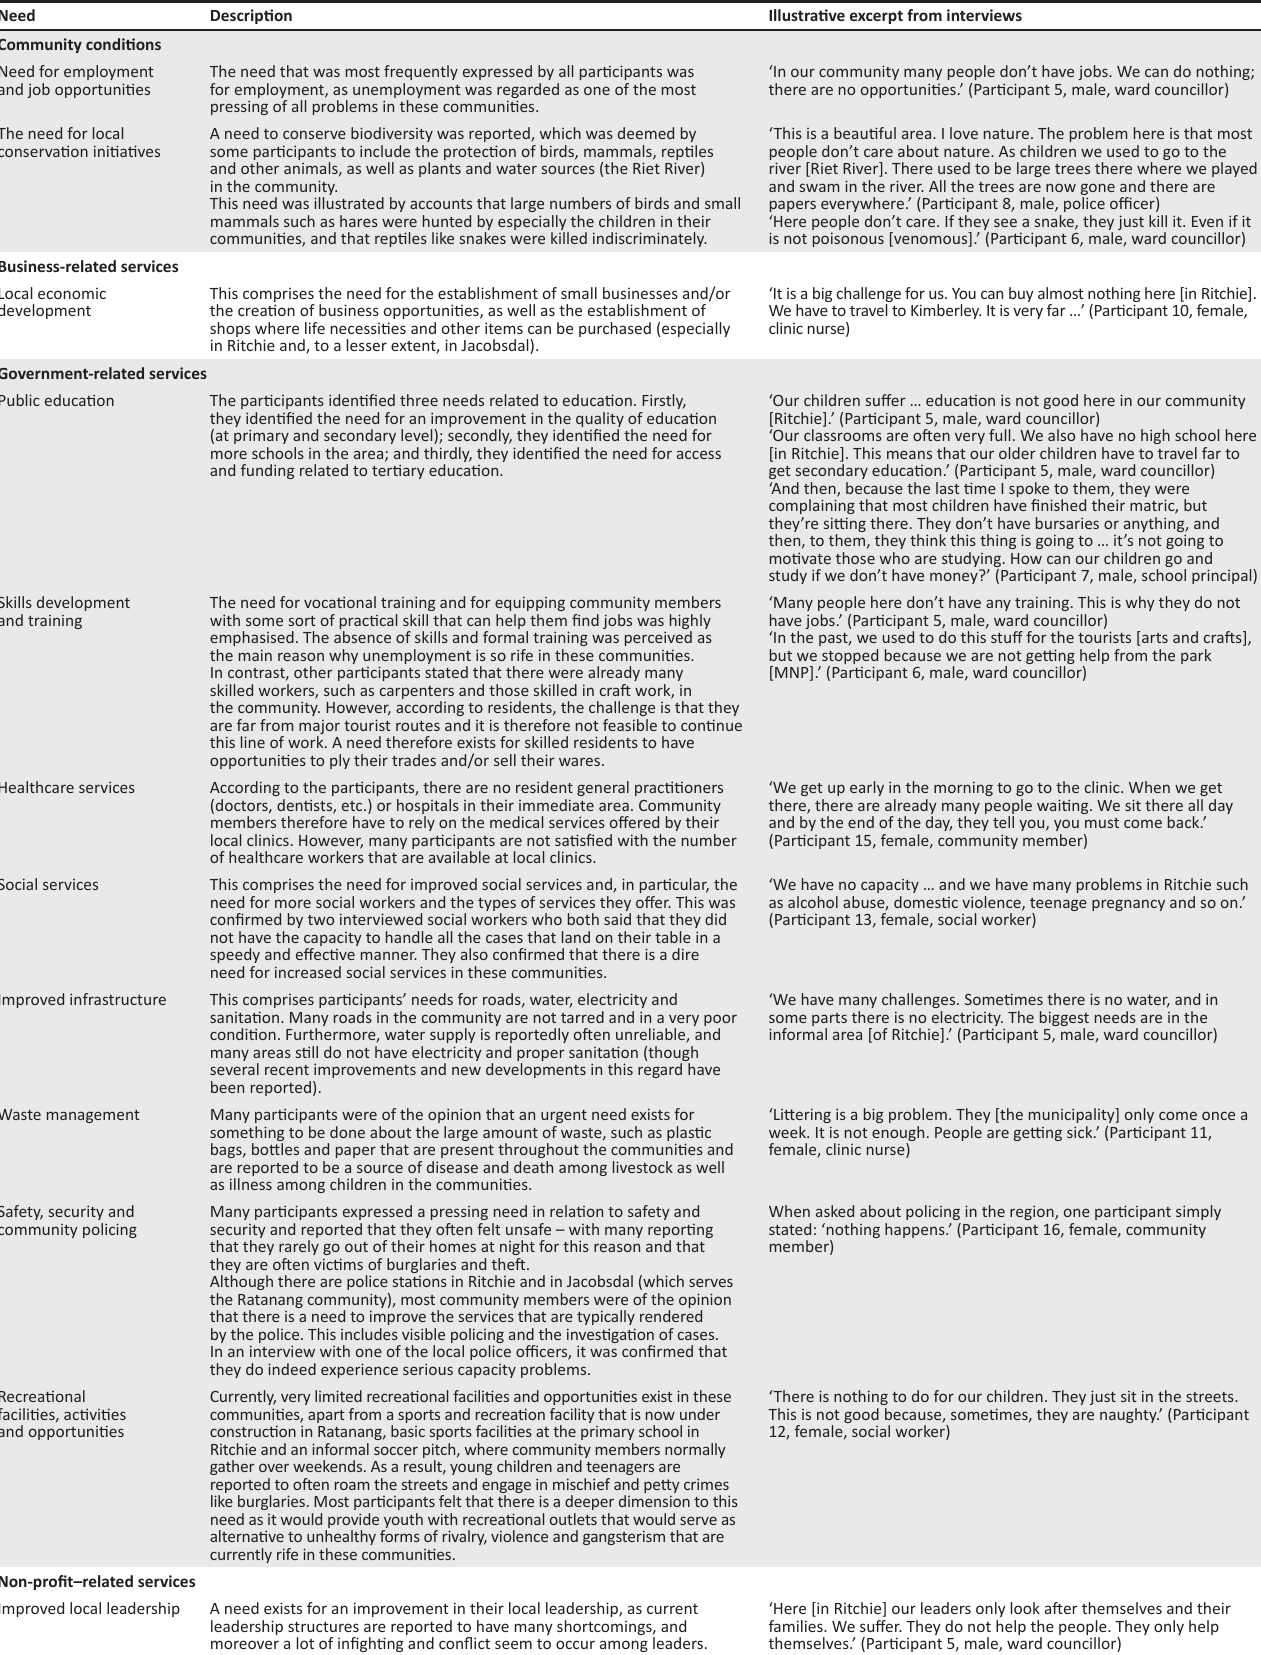
TABLE 2: Community